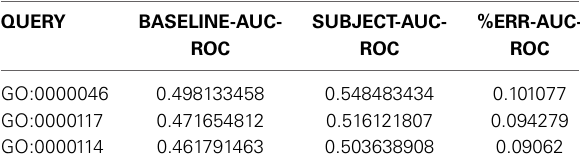
Table 1 | Median AUROC and AUPR for all networks in R6 and R8, as well as the default networks of each, respectively (bold indicates higher number per comparison).